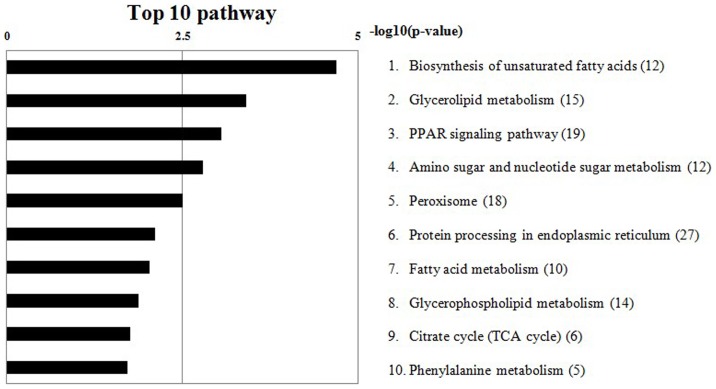
Top 10 enrichment pathways.The numbers of genes involved in the pathways are indicated in parentheses.